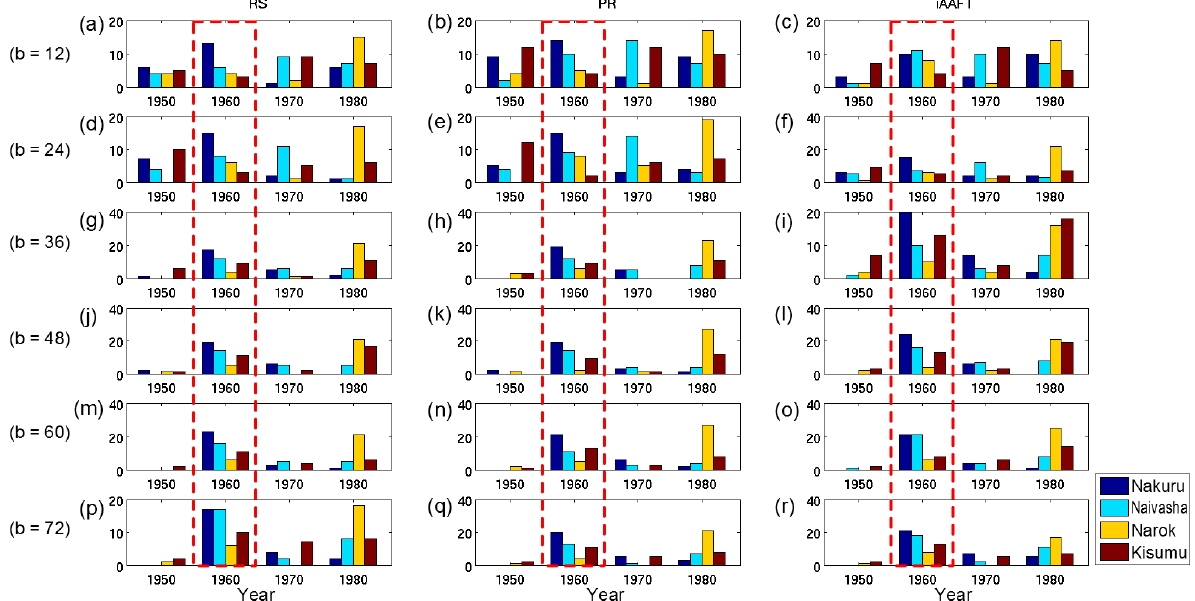
Fig. A2. Histogram, classified into the 1950s, 1960s, 1970s, and 1980s, of the significant change points of the harmonics estimated by using the three kinds of surrogate methods: RS (left panels), PR (middle panels), and iAAFT (right panels). (a–c) for b = 12, (d–f) for b = 24, (g–i) for b = 36, (j–l) for b = 48, (m–o) for b = 60, and (p–r) for b = 72. Blue bars mean Nakuru, light blue ones Naivasha, yellow ones Narok, and red ones Kisumu.